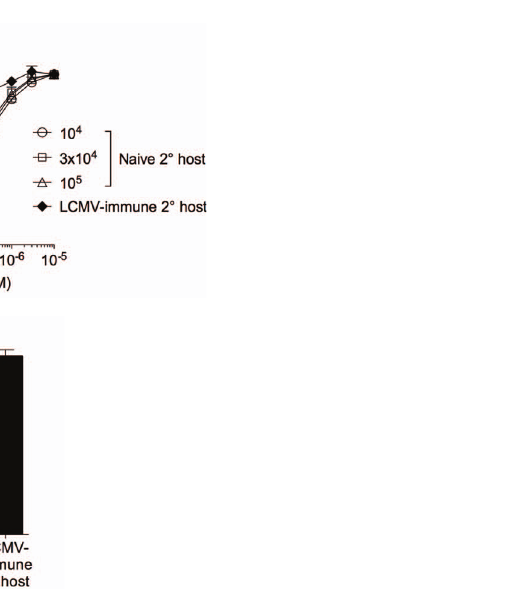
Figure 4. Functional avidity decay of memory SMARTA cells restimulated in naı¨ve secondary hosts is independent of the magnitude and duration of antigen availability. A ) We transferred 1 6 10 4 , 3 6 10 4 or 1 6 10 5 LCMV-induced SMARTA memory cells (Thy1.1 + , . 42 days post-infection with LCMV) into naı¨ve B6 secondary hosts (Thy1.2 + ) followed by challenge with Lm-gp61. Estimating a 10% ‘‘take’’ of transferred cells, the bar graph indicates the fold secondary expansion of each population of SMARTA cells in the spleen by day 7 post-infection, as compared to SMARTA cells (Thy1.1 + , 1 6 10 4 transferred) rechallenged in LCMV-immune hosts. B ) Graph indicates the functional avidity of secondary SMARTA Th1 effector cells in the spleen day 7 after transfer of the indicated numbers into naı¨ve B6 secondary hosts and challenge with Lm-gp61, or day 7 after transfer of 1 6 10 4 SMARTA cells into LCMV-immune secondary hosts and challenge with Lm-g61. C ) Bar graph indicates the EC 50 of each group of SMARTA cells, calculated as previously. D ) Bar graph indicates the frequency of Thy1.1 + SMARTA cells in the spleen for each group the simultaneously produce IFN c , TNF a and IL-2. Error bars indicate the SEM (n=4 mice/group). NS =not significant, as determined by student’s t-test.